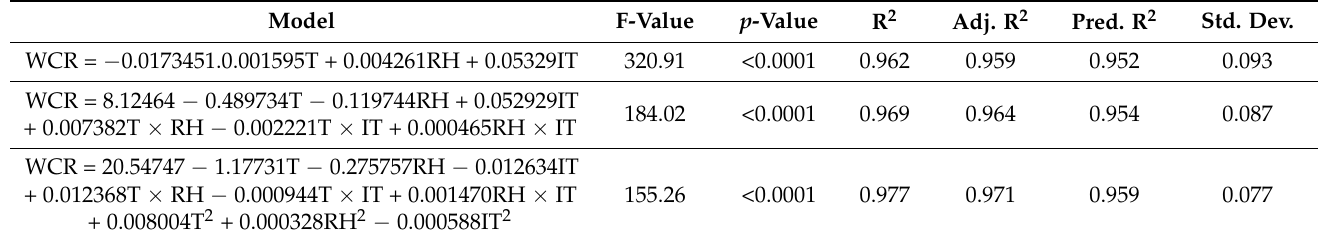
Table 4. Mathematical models under an Arduino microcontroller system in a greenhouse. Model